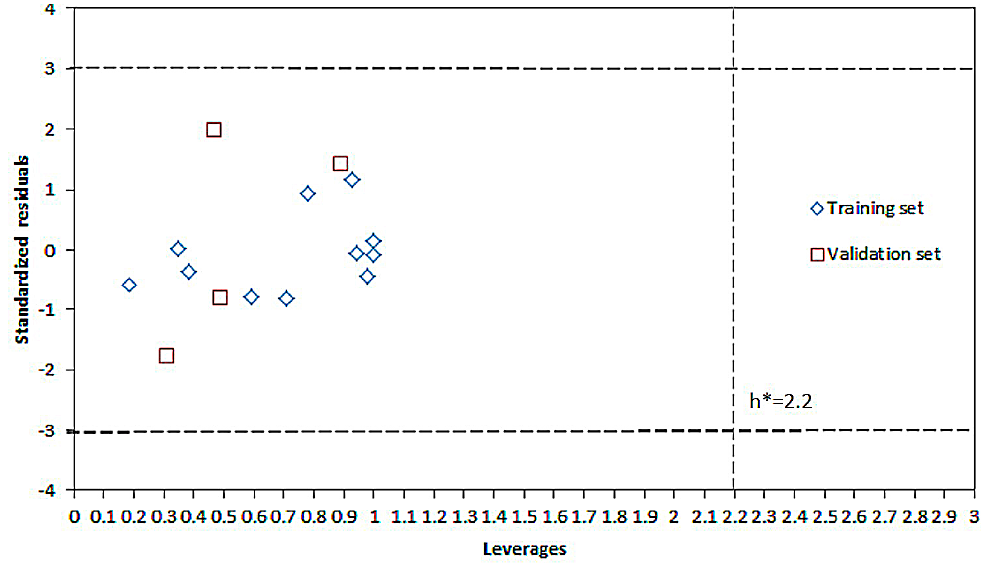
Figure 5. Williams Plot: standardized residuals versus leverages, horizontal dash lines indicate ±3 SD unites, vertical dash line indicates the threshold value h* = 2.2).